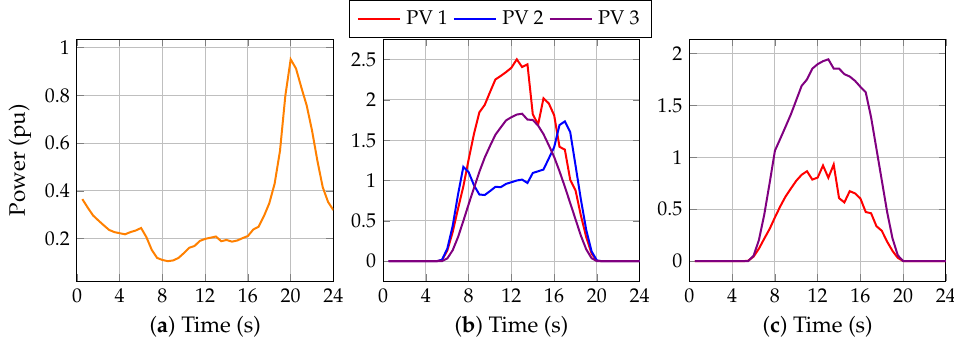
Figure 3. Optimal scheduling of PV generators: ( a ) power losses of the bipolar DC grid, ( b ) power delivered for the PV generators in the positive pole, and ( c ) power delivered for the PV generators in the negative pole.